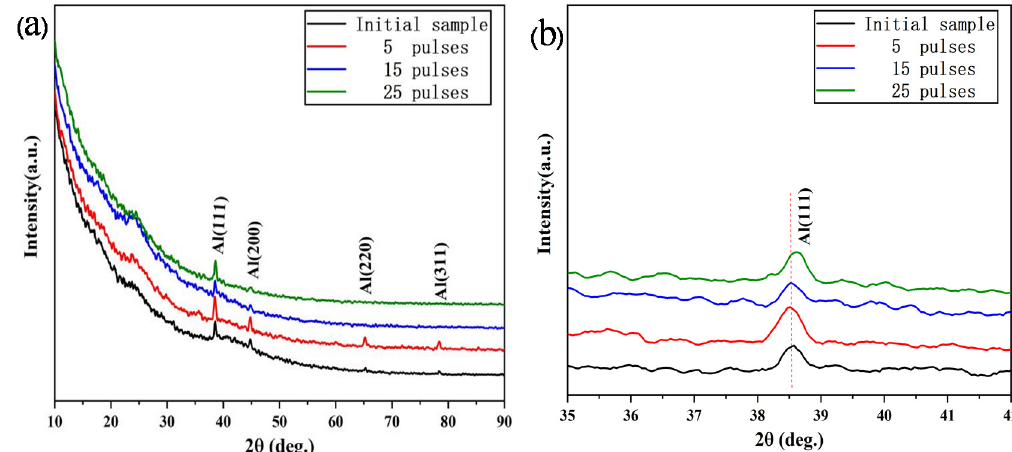
Figure 1. GIXRD patterns of the Al-20SiC-0.3CeO 2 sample before and after high-current pulsed electron beam (HCPEB) technology irradiation: ( a ) complete GIXRD pattern, ( b ) enlarged pattern of the lattice plane of Al(111).